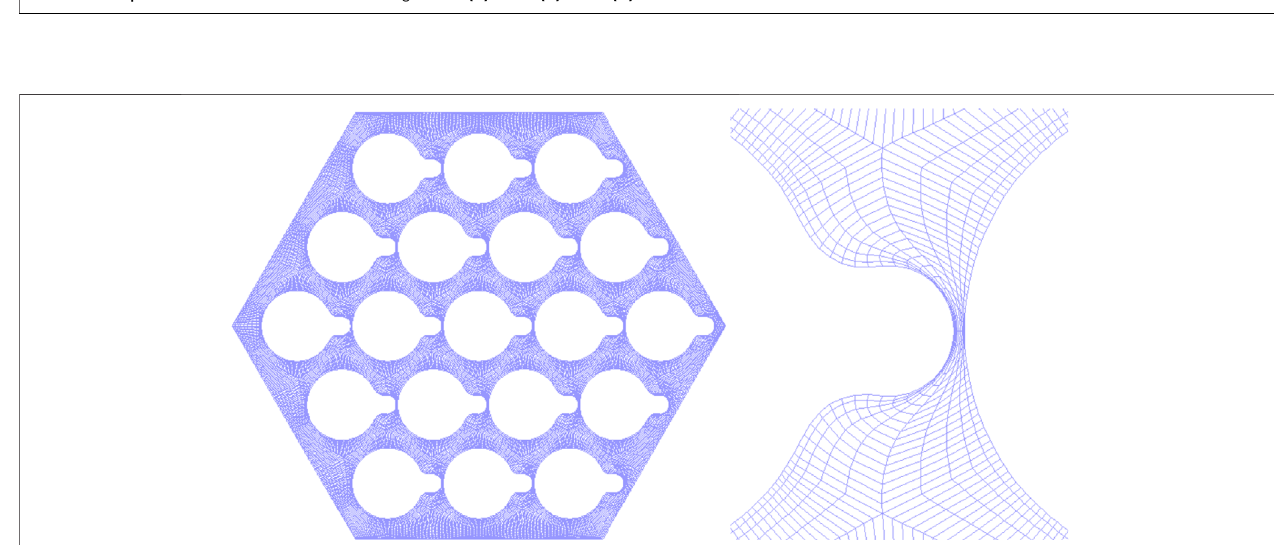
FIGURE 10 | The cross section for the measuring levels. (A) ML1. (B) ML2. (C) ML3.